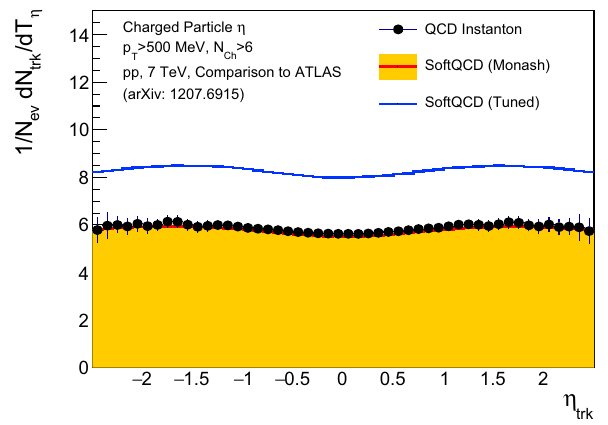
Fig. 22 Primary charged-particle multiplicities as a function of | η | for events with at least two primary charged particles with p T > 100 MeV and| η | < 2.5,eachwithalifetime τ> 300ps.Theblackdotsrepresentthe measurementofATLAS[54],whilethe softQCD predictionisproduced with Pythia8 . Also shown is a prediction which includes a contribution of 9% on Instanton induced processes. The model uncertainties are indicated by the